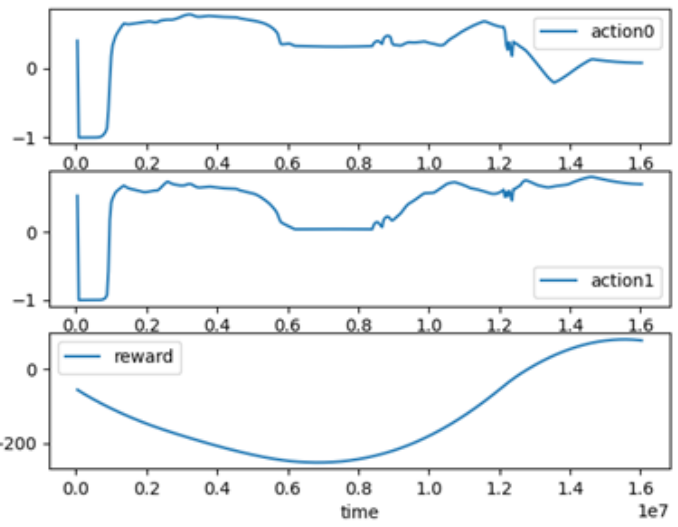
Figure A2. Example of other